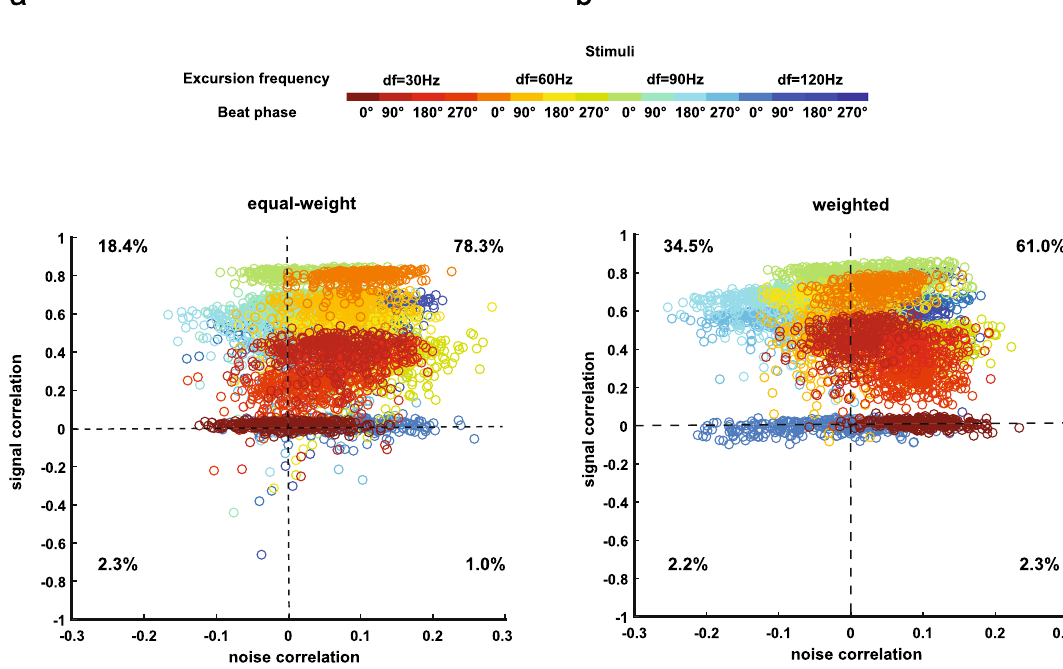
Figure 7. Weighted sums of neural activities eliminated redundancy and introduced synergy by yielding beneficial correlation structure. ( a ) Noise and signal correlations between two subpopulations, which were formed by partially summing the activities of entire population with equal weights (see “Materials and methods”). Different data points correspond to different bootstrap samples of partial sums. Percentages of data points in each quadrant are shown. ( b ) Same as ( a ) but the subpopulations were formed using weighted